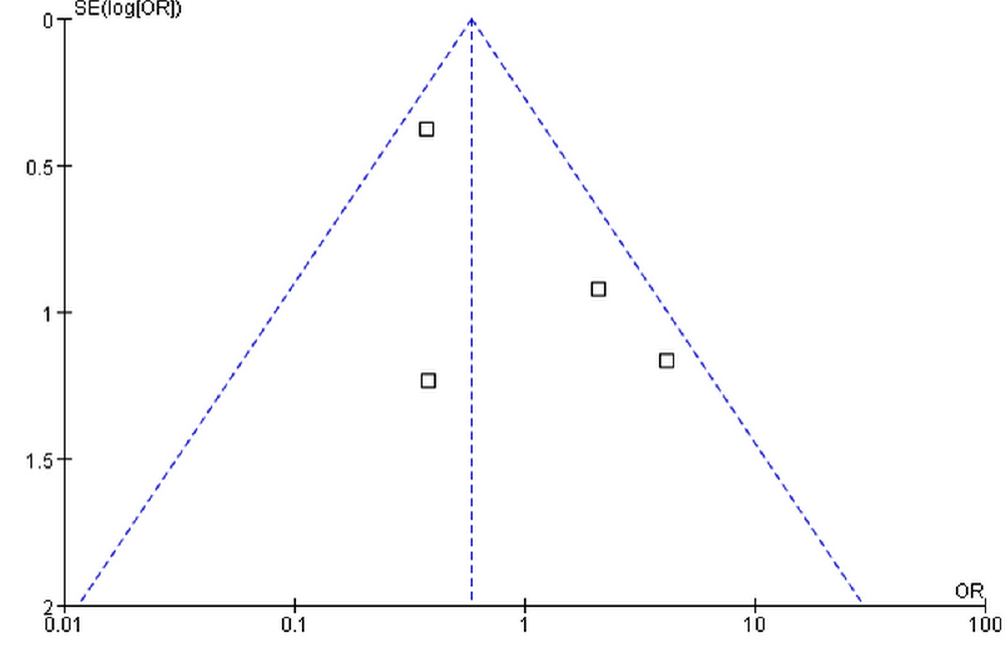
Figure 3. Funnel plot of publication bias for the association of MMP9 -1562C/T gene polymorphism with the risk of diabetic microvascular